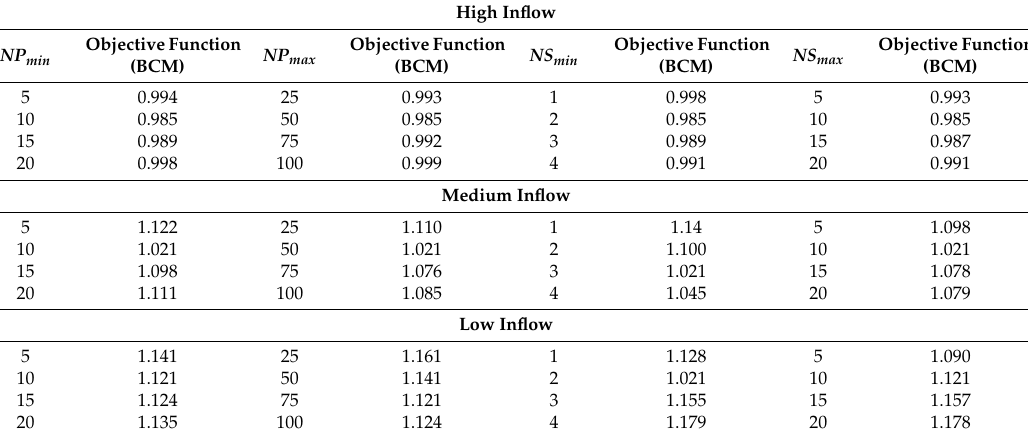
Table 2. Sensitivity analysis for IWA.